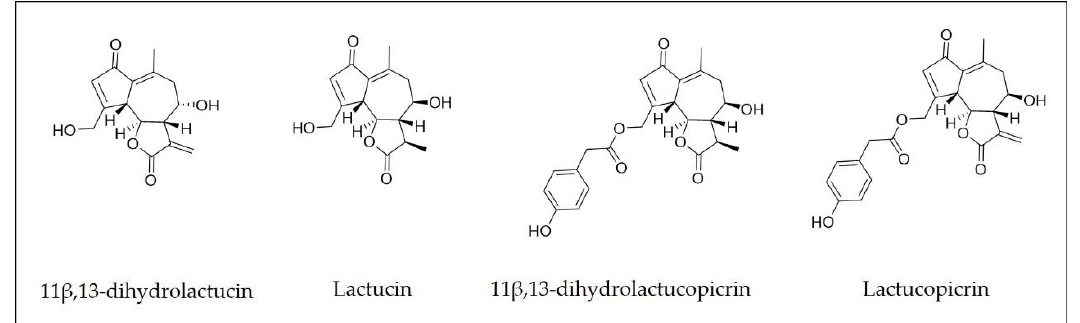
Figure 1. Major sesquiterpene lactones identified in Cichorium intybus L. root extracts. Table 1. Variables used in the two different design of experiments (DOE) and actual values of variables for the coded values. First process optimization (DOE 1) with 2 process variables, i.e., temperature and pressure, and after the final process parameters optimization (DOE 2) with 3 process variables, i.e., flow rate, co-solvent percentage, and temperature. Levels Variable,